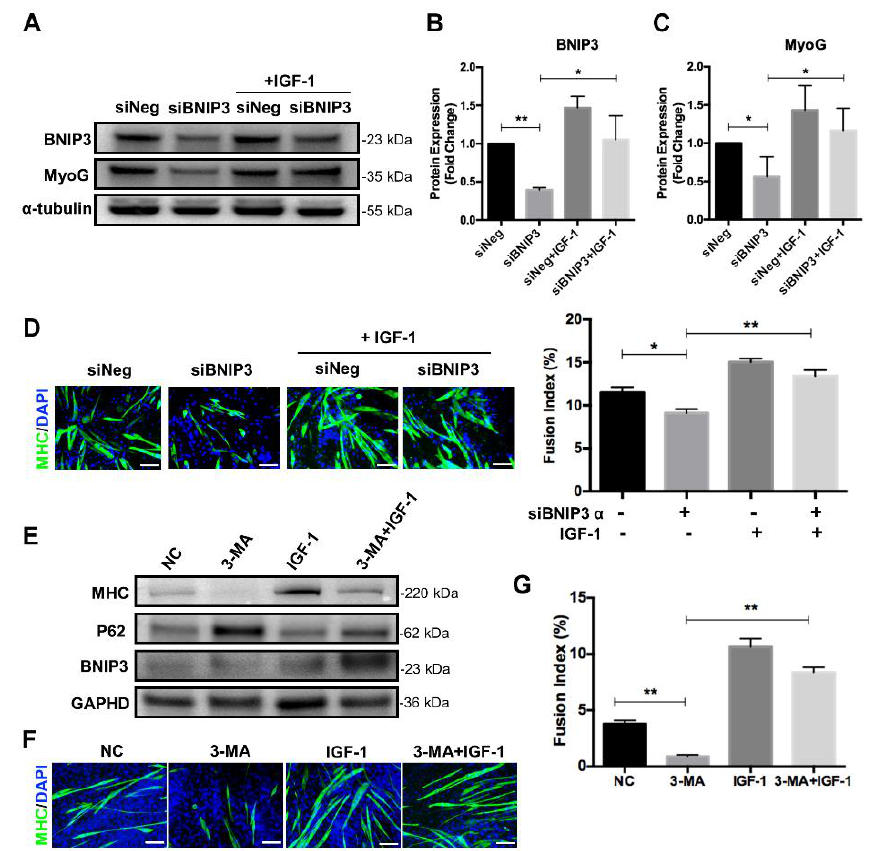
Figure 6. IGF-1 increases the differentiation potential in mitophagy- and autophagy-deficient my- oblasts. ( A – C ) Representative immunoblots and quantitative analysis of BNIP3, MyoG, and α -tubulin in C2C12 cells after 5 days of differentiation. ( D ) Immunofluorescent staining of MHC (green) and DAPI (blue) and quantitative analysis of the fusion index for siNeg and siBNIP3 C2C12 cells with or without IGF-1 treatment after 5 days of differentiation. ( E ) Representative immunoblots analysis of MHC, p62, BNIP3, and GAPDH in C2C12 cells after 5 days of differentiation in the presence of 3-MA and/or IGF-1. ( F ) Immunofluorescent staining of MHC (green) and DAPI (blue) of differentiating C2C12 cells with treatment of 3-MA and/or IGF-1. ( G ) Quantitative analysis of the fusion index. Scale bar = 100 μm. Data represent means ± SD. * p < 0.05 and ** p < 0.01.